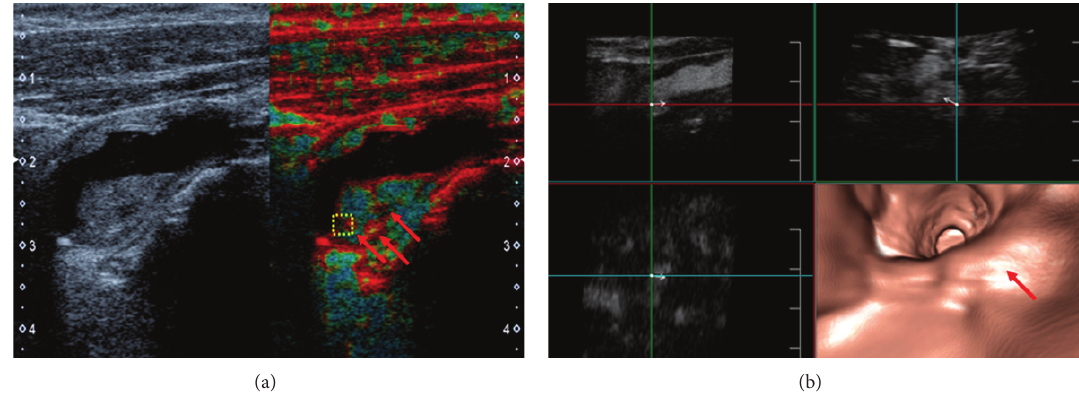
F3:(a)B-modeandtissueDopplerimaging(TDI)ofthepatient’sICAstenosis.Brighterredcoloring(arrows)indicatesincreasedelastic deformability. (b) Inverse �y-through (Flyru) technique with an intravessel view from ICA to the common carotid artery (bottom right). e red arrow marks the moderate ICA stenosis. e other three images show contrast-enhanced B-mode US used for the three-dimensional